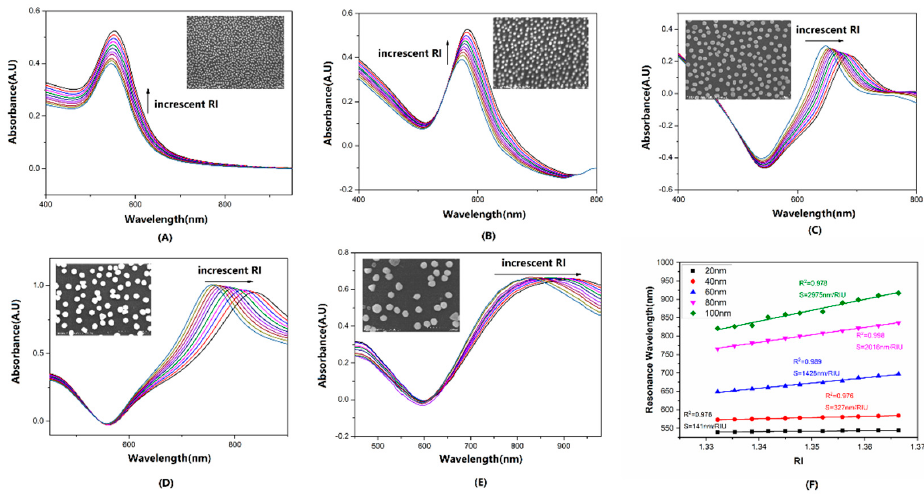
Figure 3. The absorbance spectrum series of optical fibers coated with ( A – E ) 20 nm to 100 nm AuNS in glycerol aqueous solutions with RI over the range from 1.3322 to 1.3664. ( F ) The S RI and R-squared of linear fitting for RI and λ p